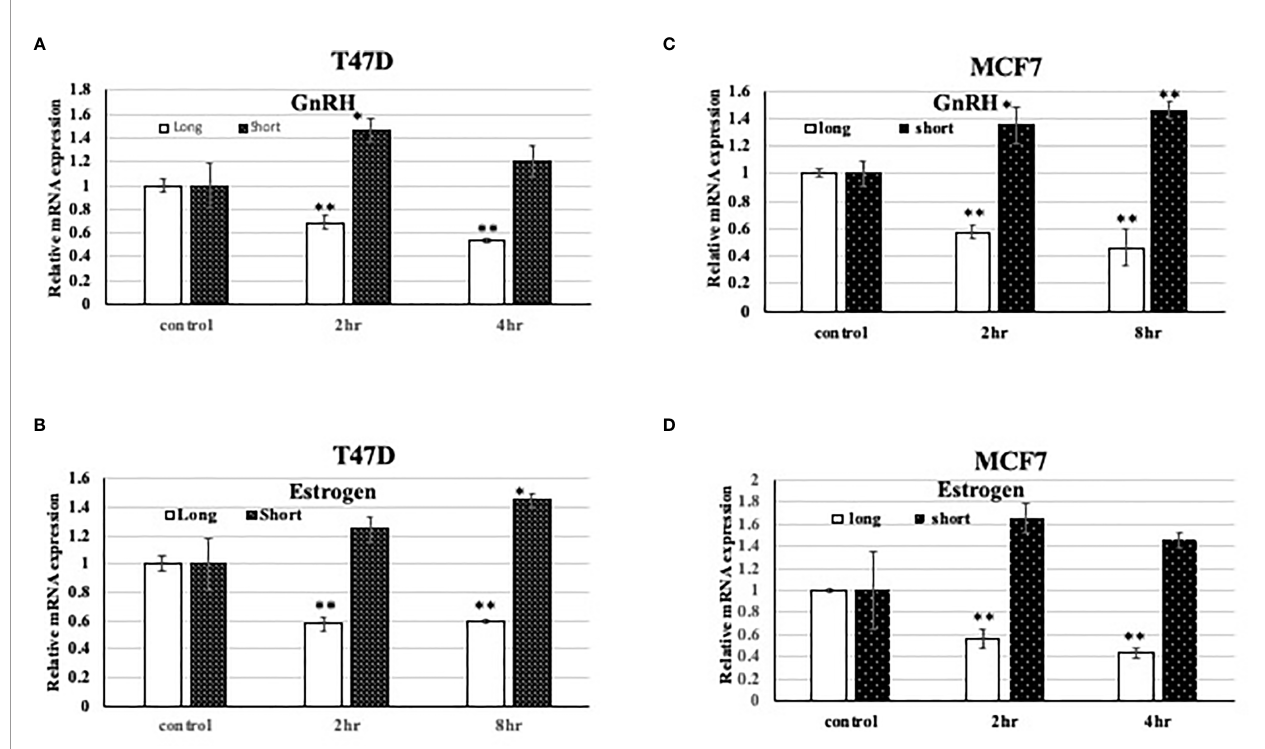
FIGURE 2 | Effect of hormone treatment on the expression pattern of TET1 isoforms in the breast cancer cell line T47D. (A – D) . qPCR results on different TET1 isoforms after treating cells with the indicated hormone for the indicated period of time. The mRNA levels are shown after normalization to the level of the housekeeping gene UBC and relative to mRNA levels in control untreated cells. Bars represent SD of the mean of three replicates. * and ** indicated p value < 0.05 and 0.01